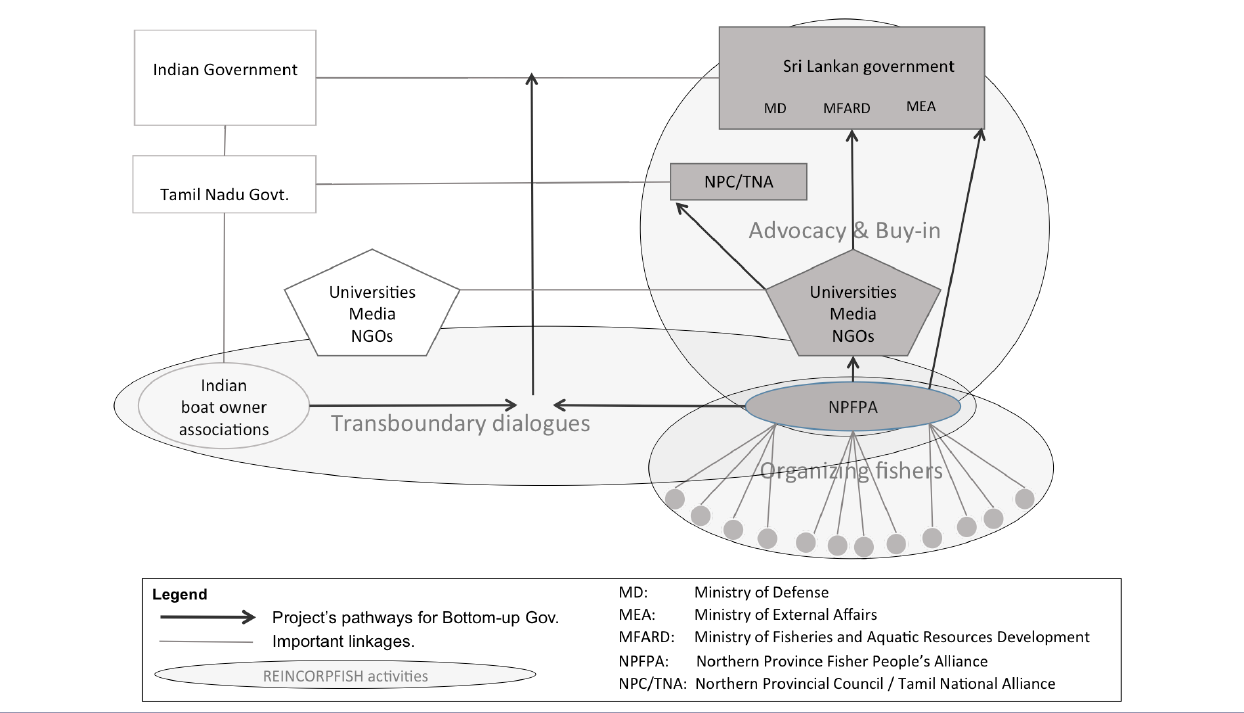
Fig. 2 . REINCORPFISH’s suggested pathways to facilitate transformation in the Palk Bay fisheries